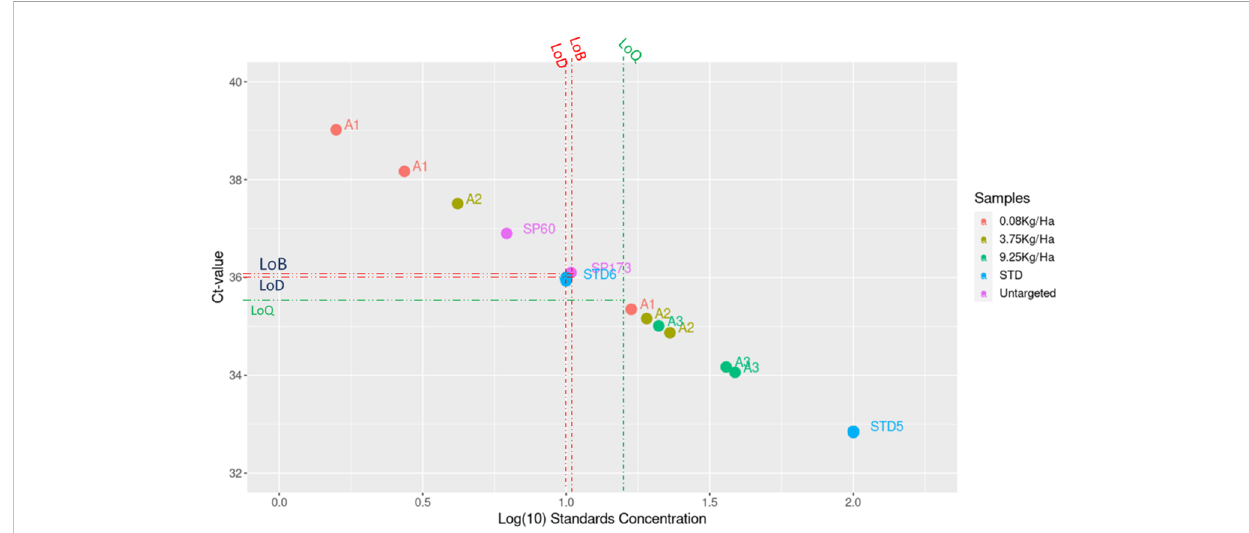
FIGURE 2 The results from different qPCR assays of in situ validation as well as the standard curve of threshold cycle number (Ct values) plotted against the log concentration (copy number). Dark green dots represent 9 replicates for each dilution. STD: the qPCR Standards. Positive control sample A1, A2, A3 with 0.08, 3.75, 9.25 kg/Ha of Atlantic cod in catch,